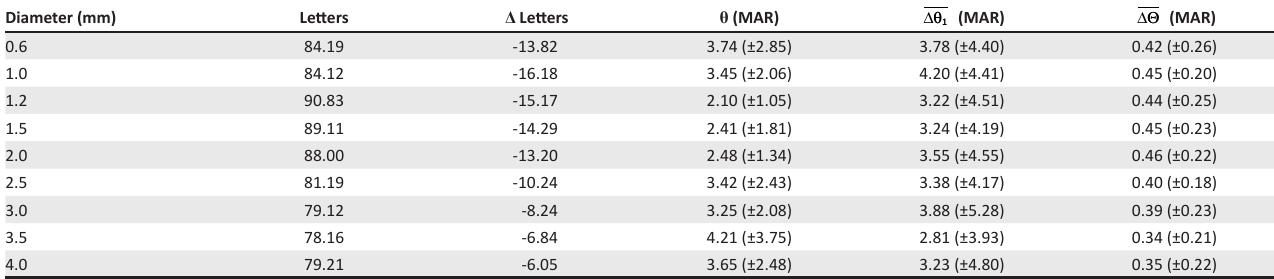
MAR, minimum angle of resolution.